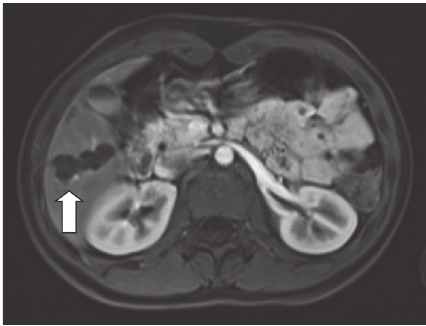
Figure 1: MRI scan of the patient no.2 after 1 month of treatment: 4 polycyclic cysts in S5/6, S7, and S8 of the